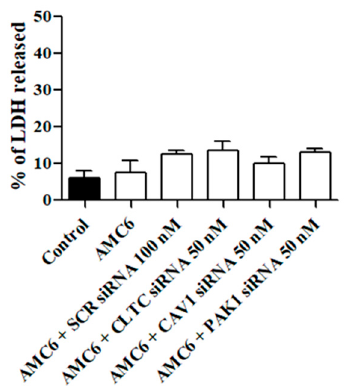
Figure 3. Effect of AMC6/custom siRNA against CLTC, CAV1 and PAK1 on cell viability. Toxicity is expressed as percentage of lactate dehydrogenase (LDH) released to the culture medium. Cells were treated with vehicle (Control), AMC6 (1 µM), AMC6 (1 µM) complexed with non-silencing scramble (SCR) siRNA (100 nM), and AMC6 (1 µM) complexed to 100 nM specific siRNA for CLTC, CAV1, and PAK1. Data are expressed as the mean ± SEM of 8 to 20 experiments.